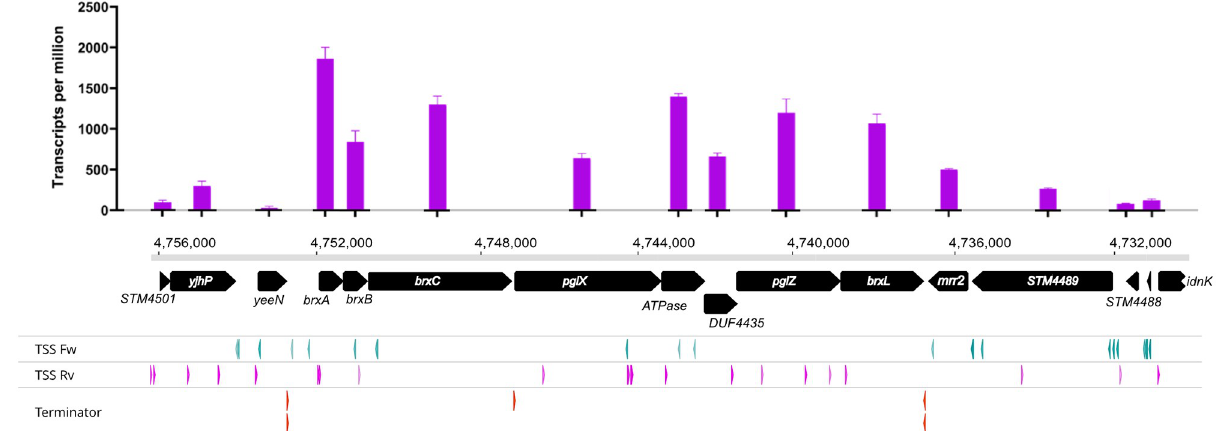
Fig 2. StySA locus operon structure analysis. The top graph represents the transcript level for each annotated CDS. Y-axis coordinates are TPM; X- axis nucleotide coordinates are from LT2 sequence NC_003197.2 (note that nt coordinates read right to left; this orients most CDS left to right). Black arrows are CDS (to scale), labelled with the BREX nomenclature of Fig 1. The BREX-related cluster comprises brxA-brxL ; on the flanks, three (left) and five (right) external CDS are included to assess transcription into or out of the locus. Below the gene schema, transcription start sites (TSS) are presented. "Fw" TSS are top strand starts for NC_003197.2, "Rv" are bottom strand starts, including BREX promoters. Rho-independent transcription terminators were predicted using TransTerm.